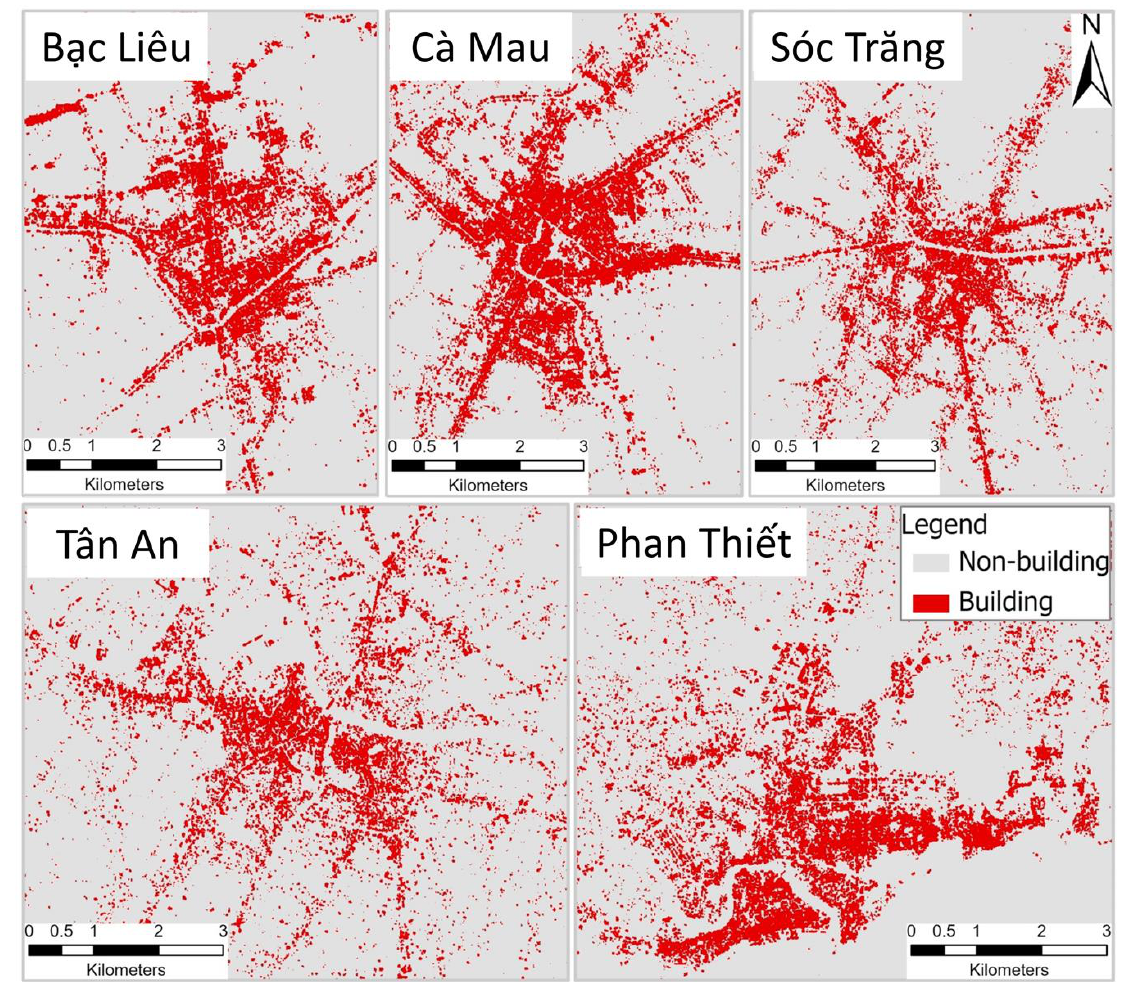
Figure 6. Classification map of five cities: Bạc Liêu, Cà Mau, Sóc Trăng, Tân An, and Phan Thiết.